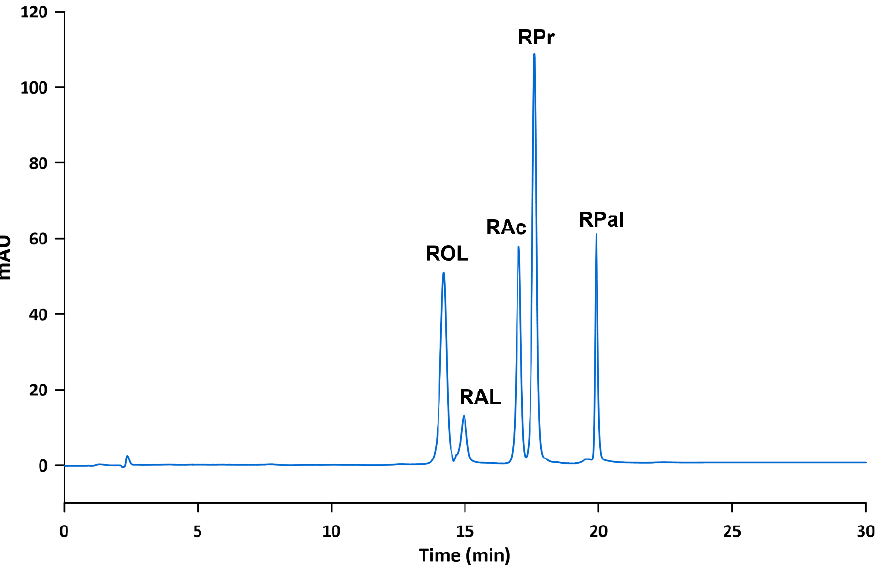
Figure 1. Chromatogram of a standard solution containing the analytes at 10 µg mL −1 obtained according to the proposed method.